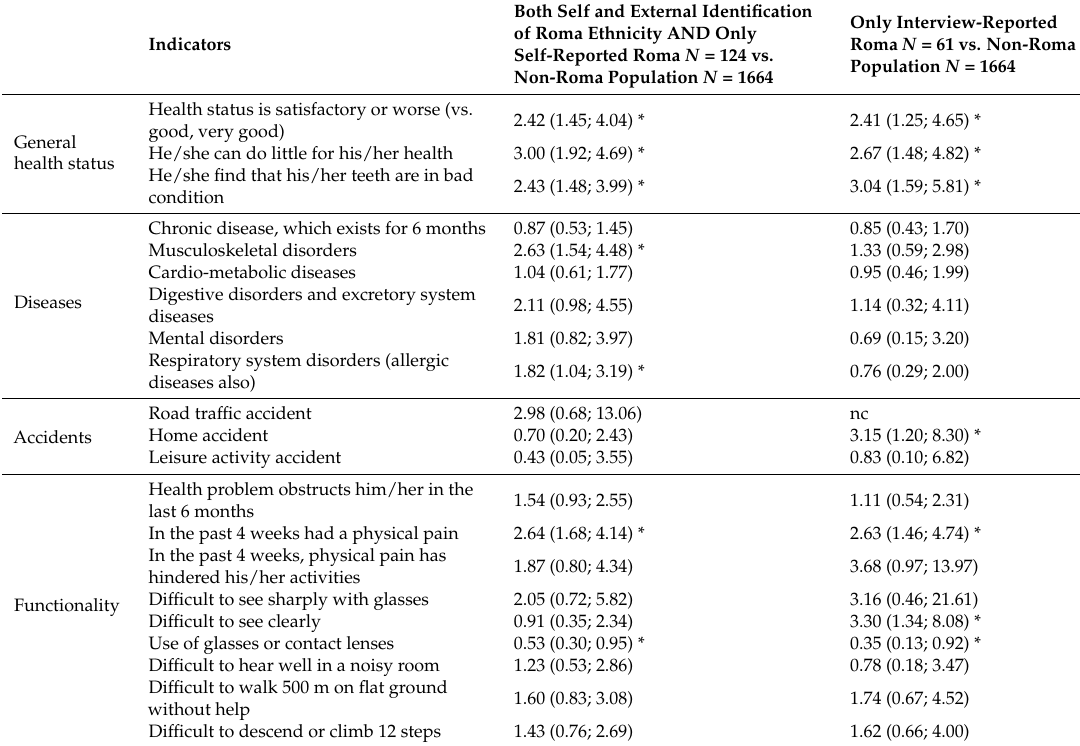
Table A1. Health risks among the Roma compared to non-Roma (according to both self and interviewer ethnicity assessment) by self-reported and by ONLY the interviewer-reported Roma ethnicity (odds ratios with 95% confidence intervals in square brackets from one multivariate logistic regression model controlled for age, sex, education and